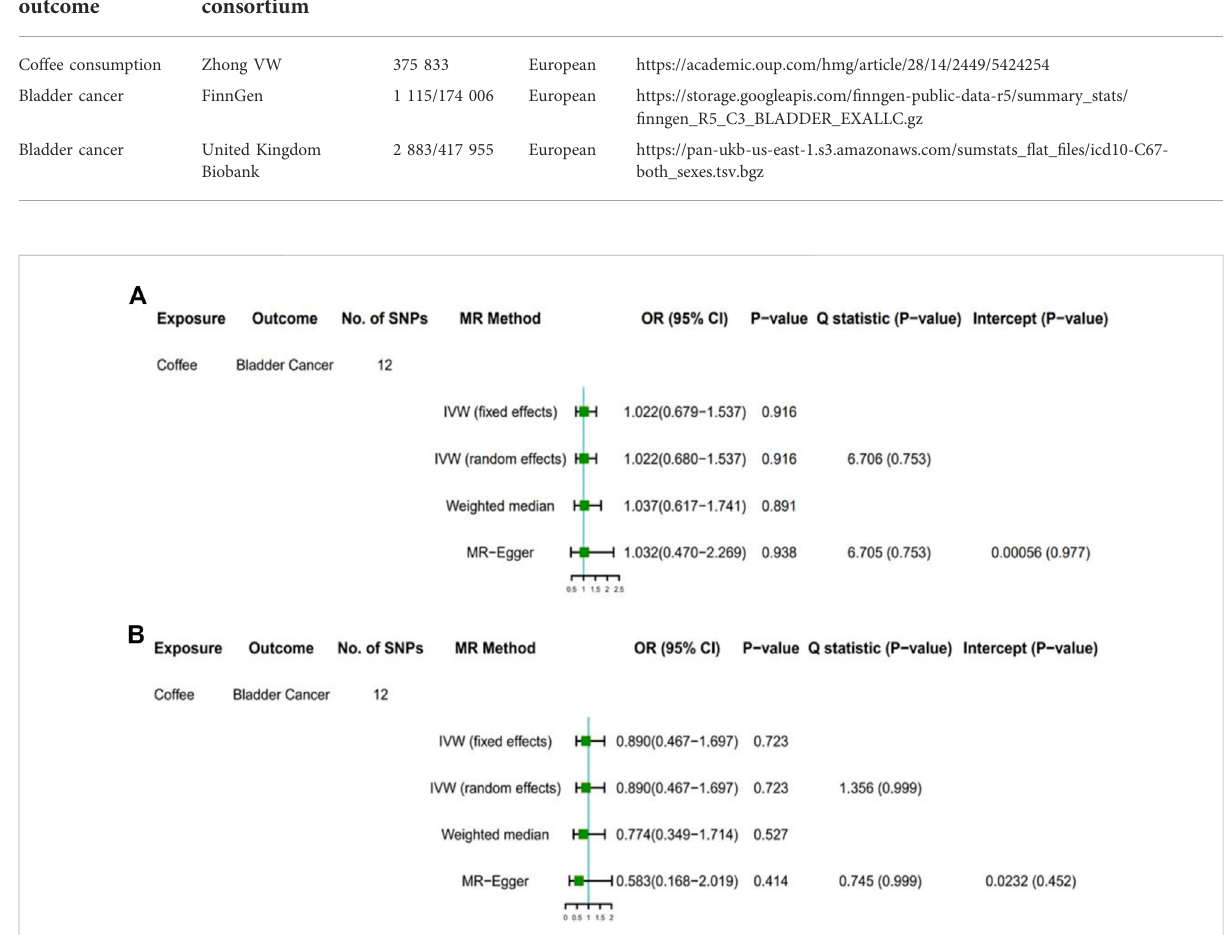
FIGURE 1 Results of primary analyses. Association of genetically predicted coffee consumption with bladder cancer risk in the United Kingdom Biobank (A) and FinnGen consortium (B) OR, odds ratio; CI, con fi dence interval; SNP, single-nucleotide polymorphism.